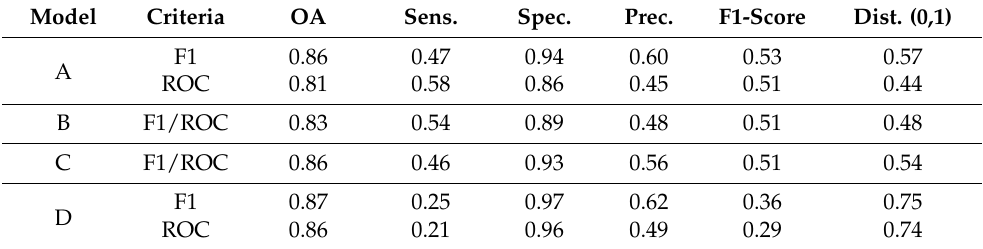
Table 6. Results of the multilayer perceptron (MLP) neural network (NN) with the best parametric configuration for each variable combination. Criteria for the selection of the best model are maximum F1-score (F1), minimum distance to the optimal point (0,1) in the operating receiver characteristics curve (ROC) or both (F1/ROC). All the metrics are computed from the validation set. (OA: overall accuracy; Sens.: sensitivity; Spec.: specificity; Prec.: precision; Dist. (0,1): distance to the point (0,1) in ROC